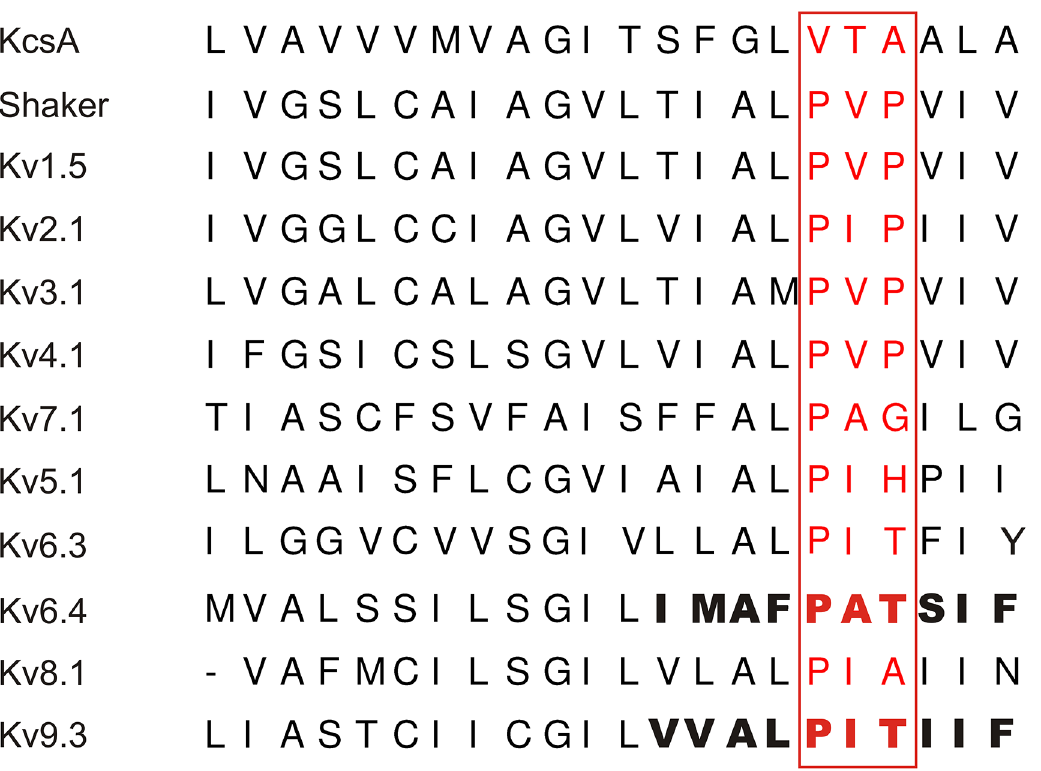
Fig 1. Sequence alignment of the S6 segment of various Kv and KvS subunits. The PXP motif (red) is conserved between the Shaker and Kv1 − Kv4 subunits. The Kv7.1 subunit displays a glycine (could confer flexibility) while the Kv5, Kv6, Kv8 and Kv9 (or KvS) subunits contain residues that would promote an alpha − helical configuration. The S6c segment used to make the chimeric substitution between Kv6.4 and Kv9.3 is highlighted in bold.